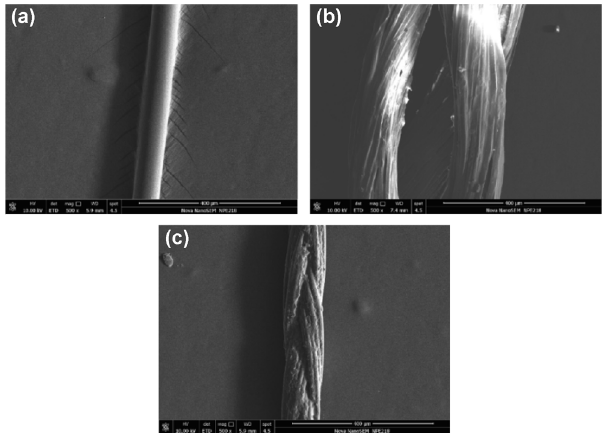
Fig. 9 SEM micrographs of surgical sutures: (a) wet nylon, (b) wet silk, and (c) wet